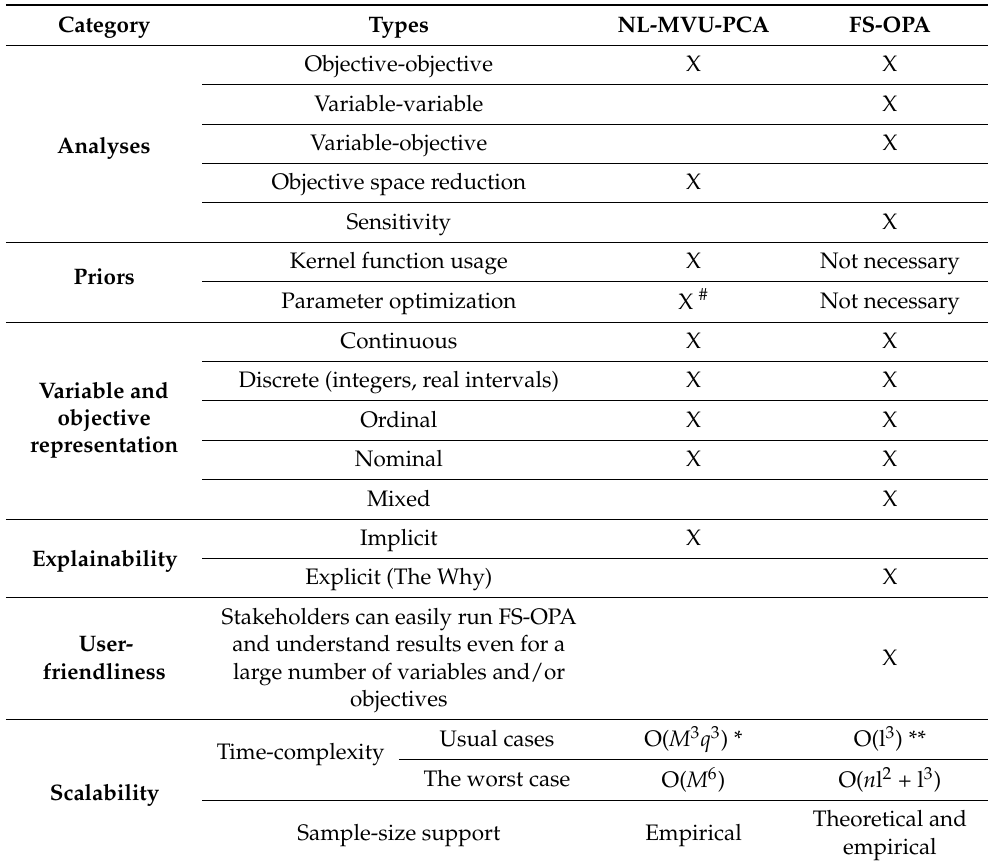
Table 1. NL-MVU-PCA and FS-OPA for multidimensional data-driven structural learning applied to real-world